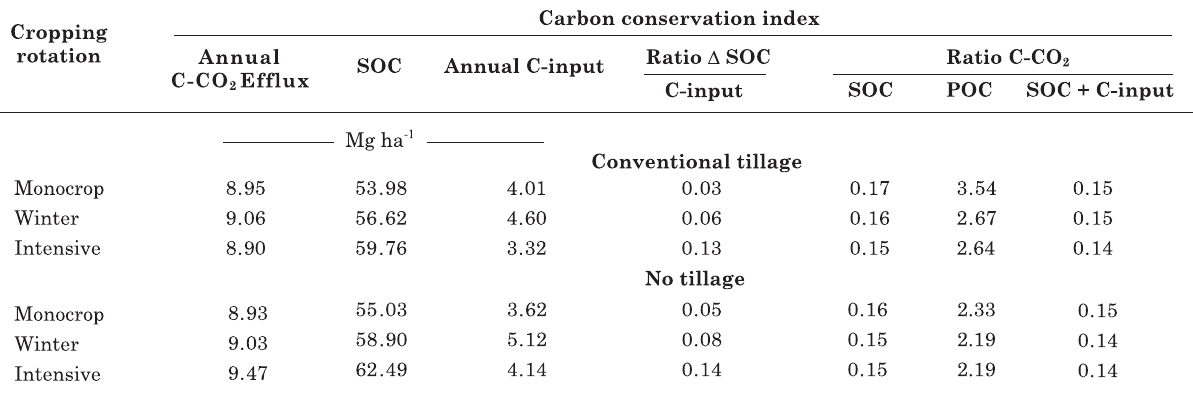
Table 2. Carbon conservation indexes under conventional tillage and no tillage and different crop